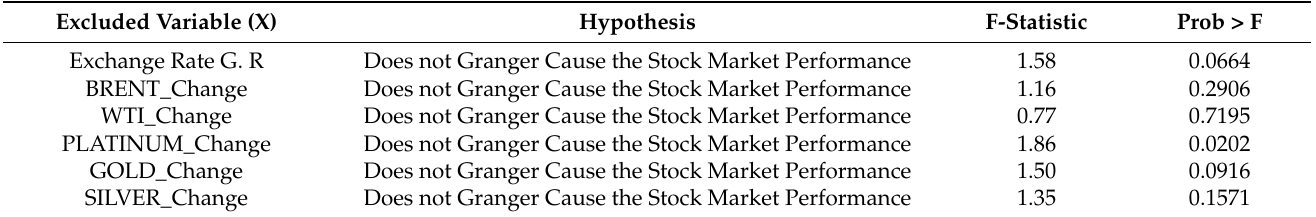
Table A10. Granger Causality test related to the Stock Market Performance (Results from the Regression with Driscoll–Kraay Approach).